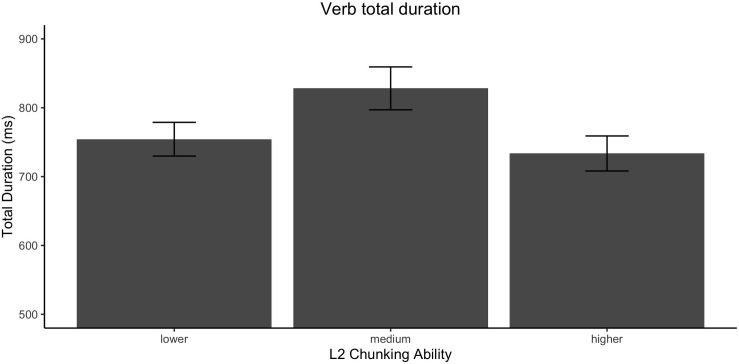
Effect of each tercile of L2 chunking ability on total duration times for the verb. Error bars represent the standard error.